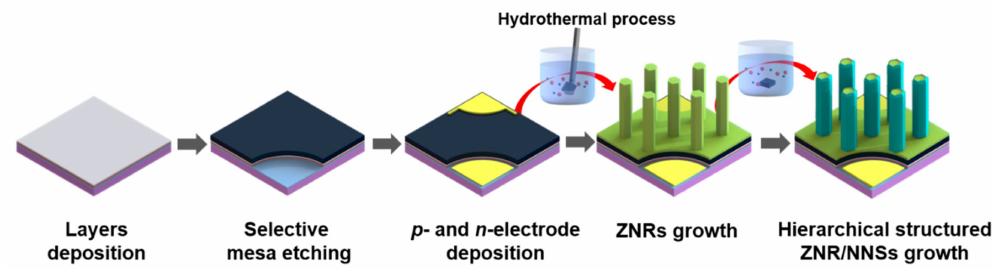
Figure 1. Fabrication process of C-emitter with hierarchical ZnO nanorod (ZNR) / NiO nanosheet (NNS) arrays.